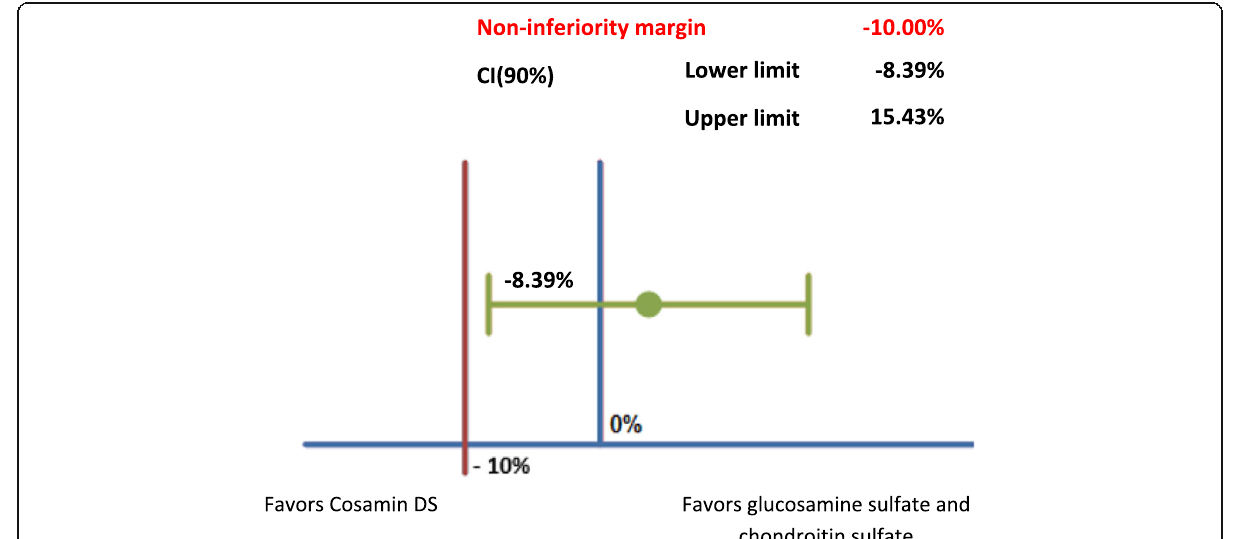
Fig. 2 Evaluation of glucosamine sulfate and chondroitin sulfate non-inferiority vs. Cosamin DS® according to analgesic efficacy evaluation by the investigator in the PP population ( N = 86)